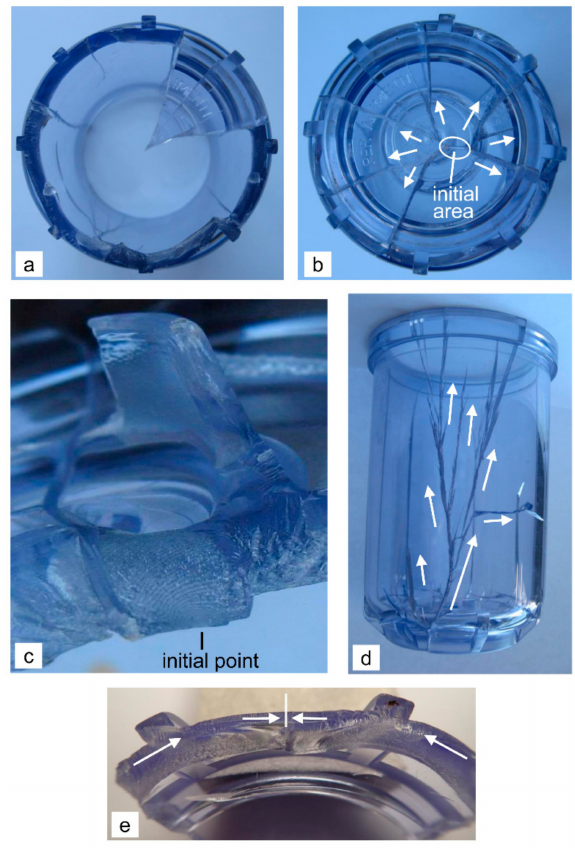
Figure 4. Specific characteristics of the initiation and propagation of the cracks in the sample of series C ( a ) the breaking base ( b ) an initiation area in the central thickened cylindrical part of the base and radial spreading of the cracks through the base ( c ) an initiation point on the external side of the thickened cylindrical part ( d ) the branched upwards-growing crack ( e ) the oppositely growing horizontal cracks joining at the middle of the fracture in the arc of the circular sector’s fragment; the arrows indicate the direction of the crack